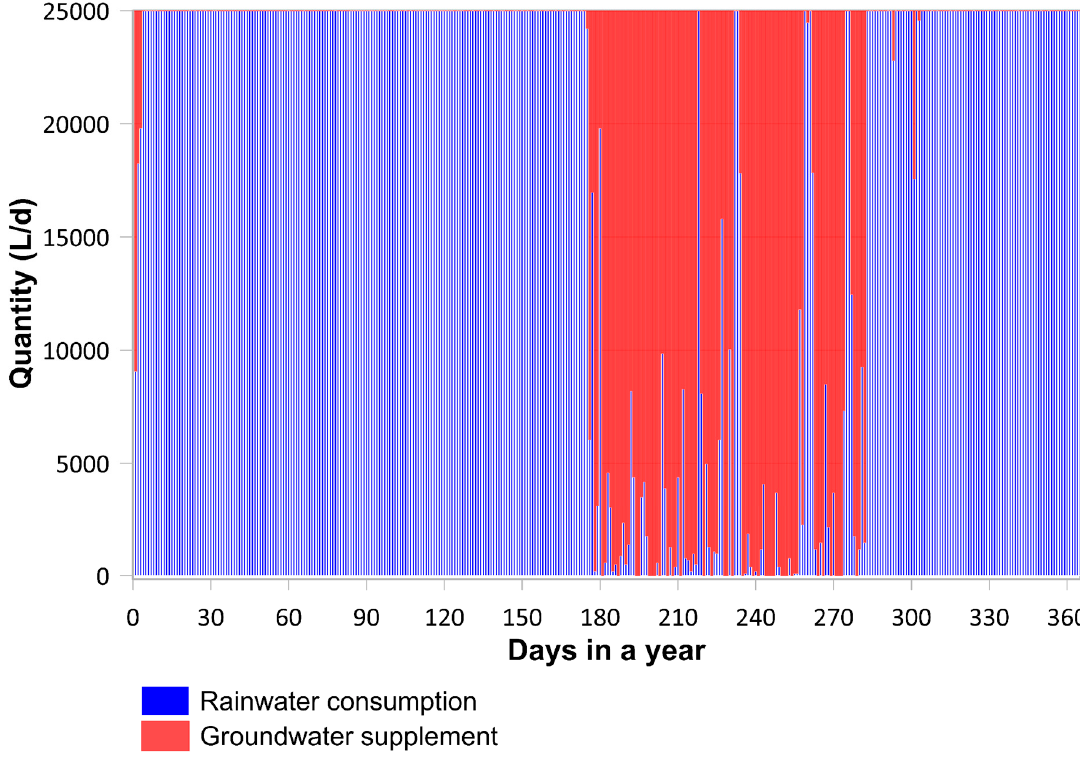
Figure 5. Daily rainwater consumption and required supplement to meet at demand of 25 L/person/d at NM ‐ AIST with a target maximum population of 1000 people.